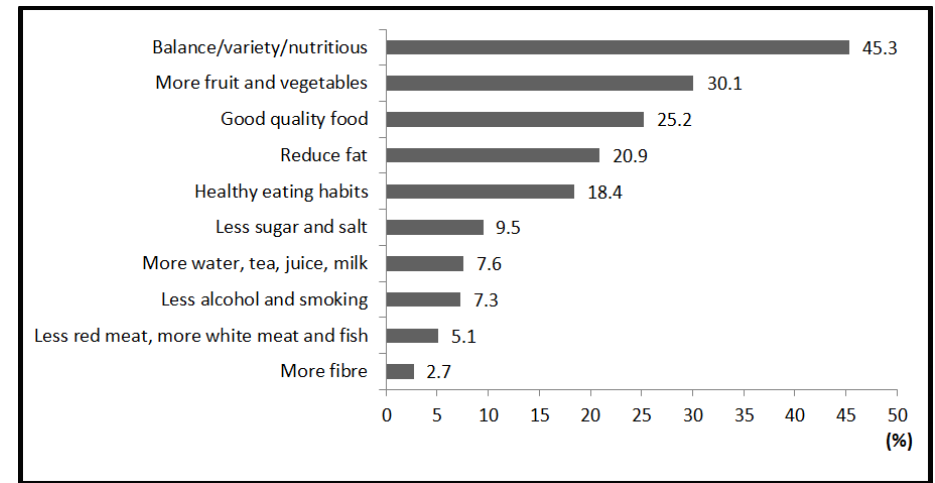
Figure 1. Ten categories of “healthy diet” defined by participants ( n = 369). Reduce fat: includes less saturated fat, less fatty food, fast food or junk food. Good quality food: includes fresh, natural, organic